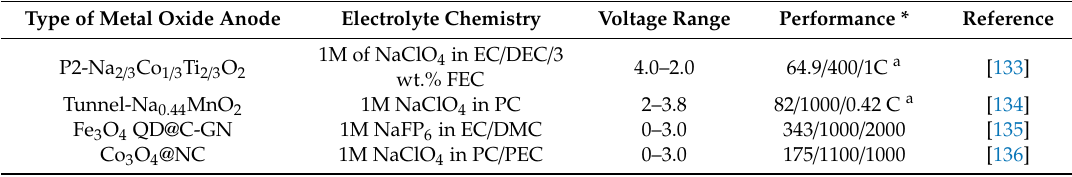
Table 3. High performance of metal oxides anodes in Na-ion battery